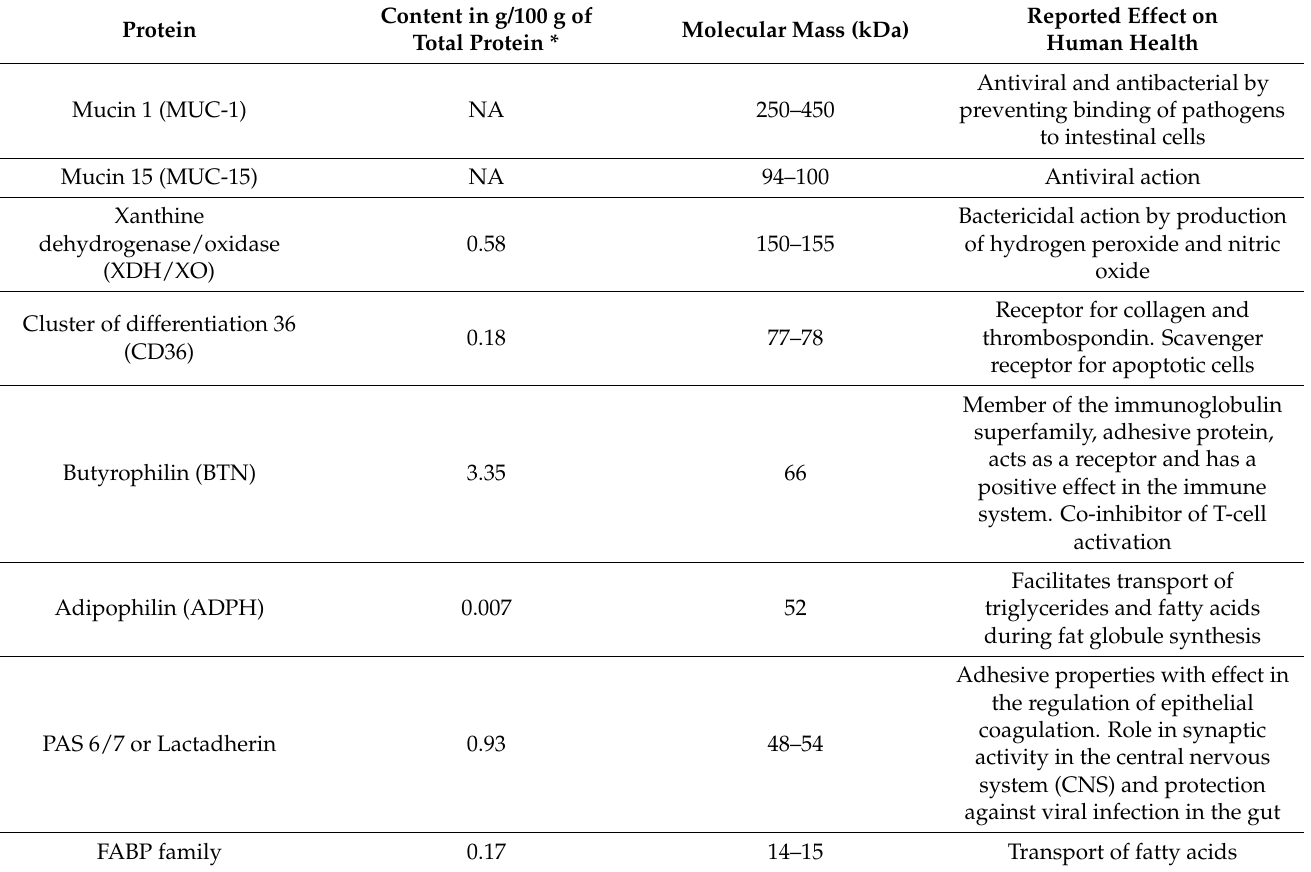
Figure 2. Variability of the milk phospholipid (MPL) profiles of different mammalian species. Data compiled from [28–33]. Table 3. Composition of the predominant MFGM proteins. Data compiled from